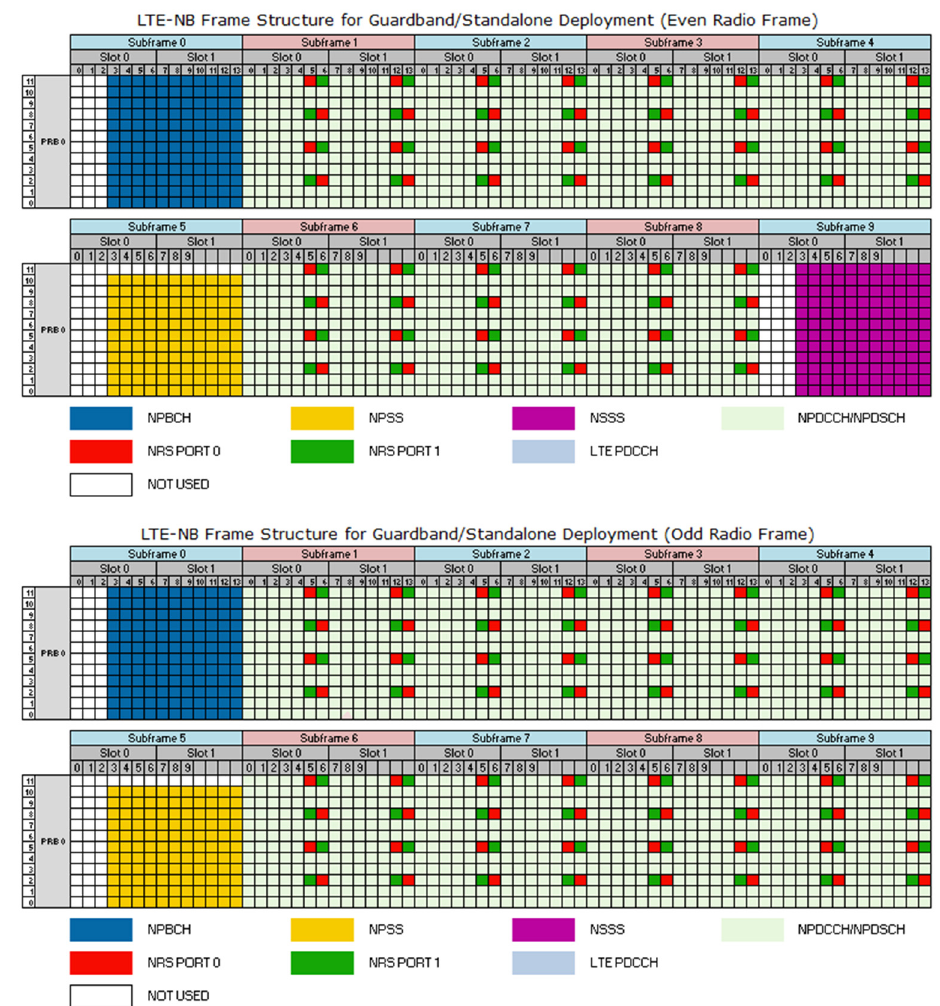
Figure 4. Allocation scheme of channels and signals in even frames (up) and odd frames (down) in guard-band and stand-alone mode [32].